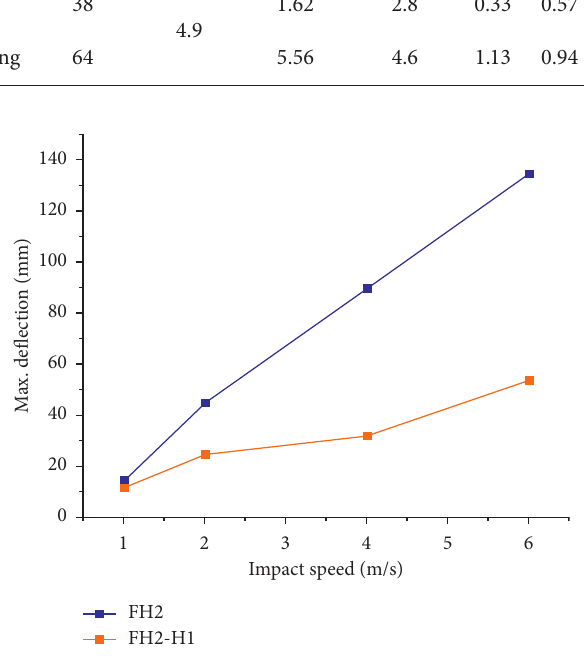
Figure 12: Speed-maximum deflection